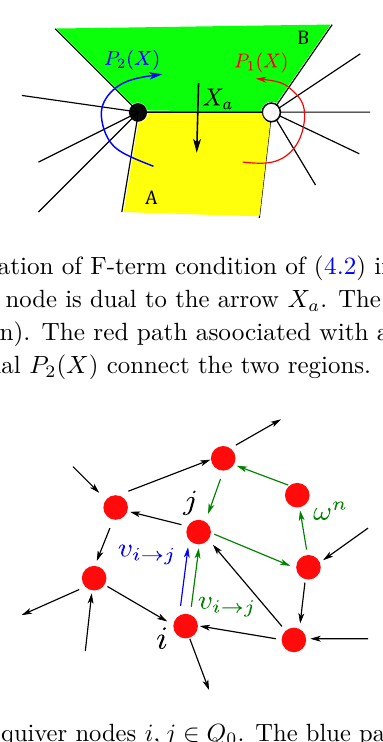
and the loop part ω n . i → j